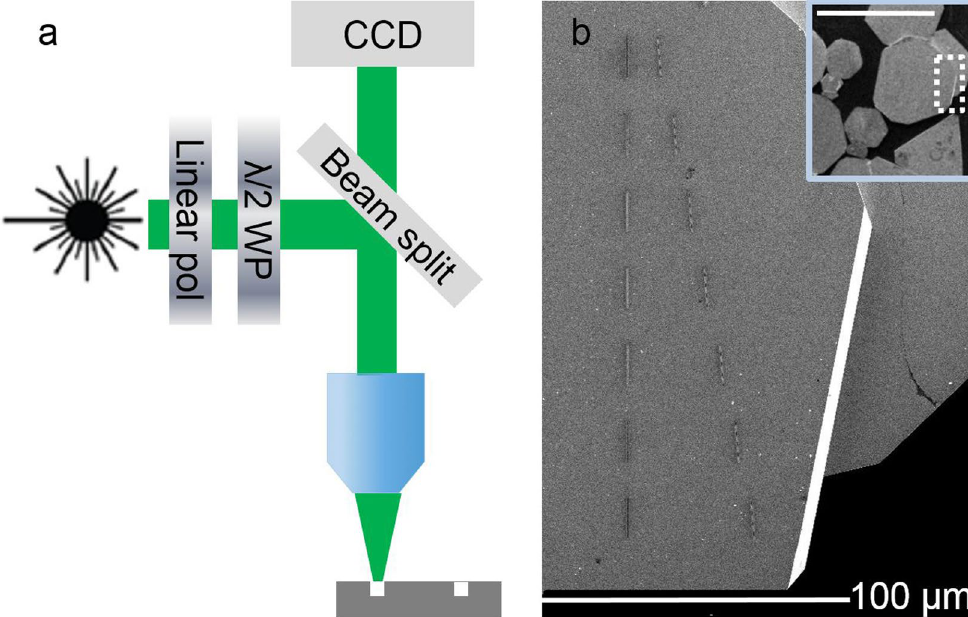
Figure 1. Illustration of experimental setup and SEM image of chemically synthesized silver plates. ( a ) Incident laser at 532 nm is focused on the input groove by an objective lens after a linear polarizer and half waveplate. Scattered SPPs signal from the output groove is collected by the same objective lens and sent to CCD. ( b ) SEM image of the groove pairs. Vertical grooves at left side are input grooves. Output grooves with a 5 degree tilt with respect to the input grooves are milled at different distances away from the input. Inset is an image of the silver plate at low magnification. Dashed line indicates the area of the main figure. Scale bar in the inset is 500 μ